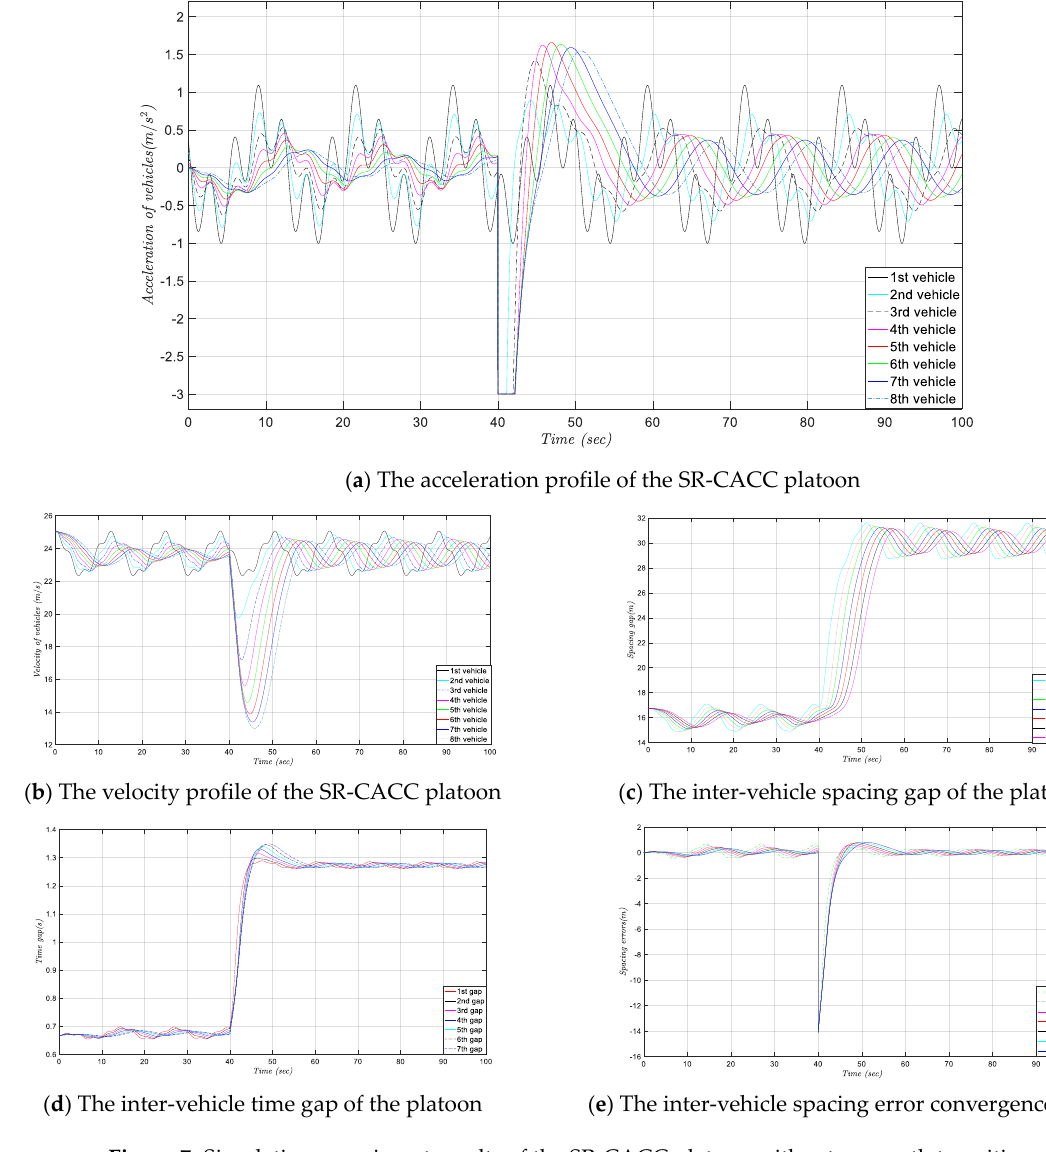
Figure 7. Simulation experiment results of the SR-CACC platoon without a smooth transition.